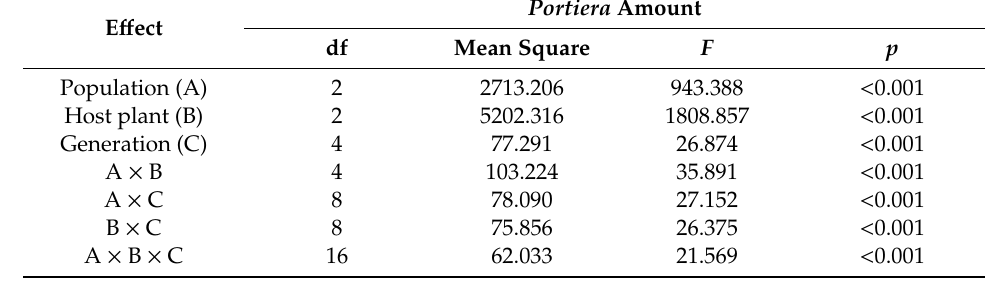
Table 2. Effects of the B. tabaci population, host plant, and generation number since host-plant-shifting on Portiera abundance, determined by three-way ANOVA. df: degrees of freedom. Effect